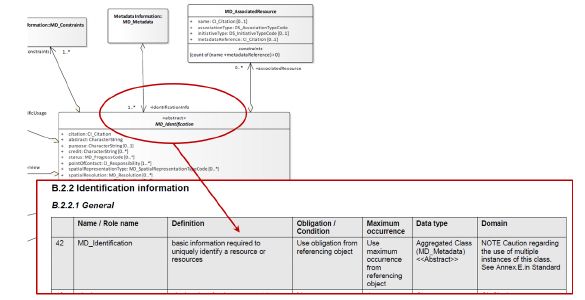
Figure 2 Resource identification information and related obligation as defined in (GA, 2014)